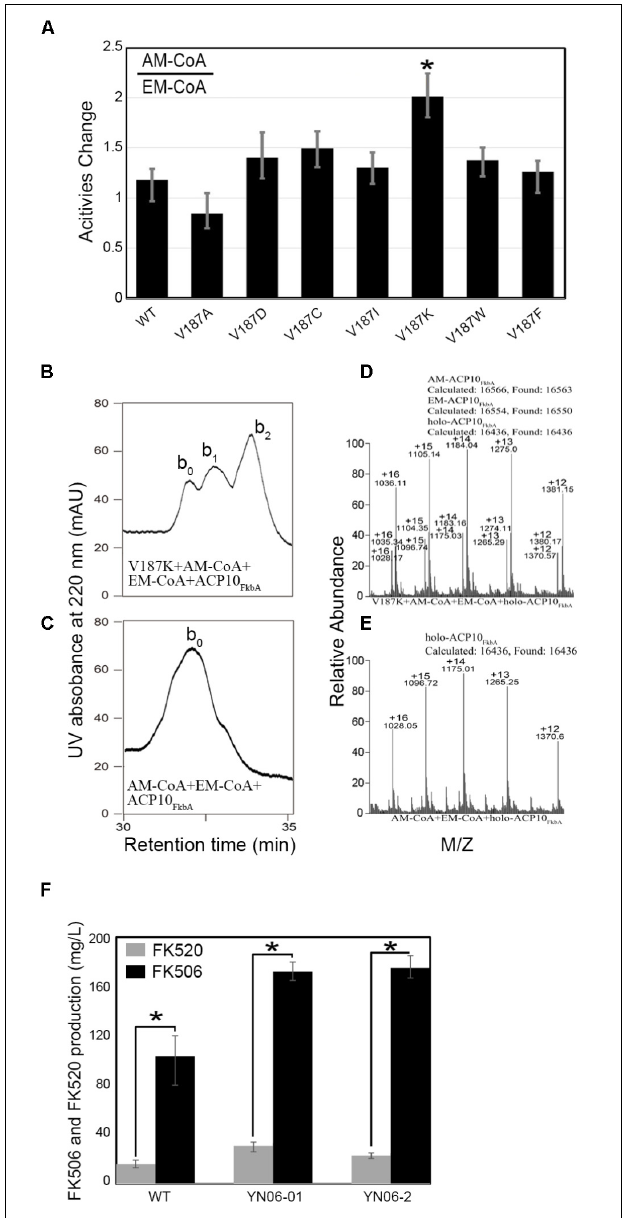
FIGURE 4 | Trans -acylation reaction assays of various AT4 FkbB mutants after substitution of Val187 with Asp, or Cys, Ile, Lys, Trp, and Phe with allmal- and ethmal-CoA as substrates and the Production of FK506 and FK520 in WT, YN06-01, and YN06-02. (A) The change of transferring allmal/ethmal unit to ACP10 FkbA in trans -acylation reactions by AT4 FkbB and its mutants V187D, V187C, V187I, V187K, V187W, and V187F. HPLC analyses of transferring allmal-CoA : ethmal-CoA = 1:1 to holo-ACP10 FkbA in the presence of V187K (B) and in the absence of AT4 FkbB (D) . MS analyses of transferring allmal-CoA : ethmal-CoA = 1:1 to holo-ACP10 FkbA in the presence of V187K (C) and in the absence of AT4 FkbB (E) . The peaks were assigned as follows: b 0 , holo-ACP10 FkbA ; b 1 , allmal-ACP10 FkbA ; b 2 , ethmal-ACP10 FkbA . (F) Production of FK506 and FK520 in WT, YN06-01 and YN06-02. Analyses of variance were conducted to determine the difference of WT and mutants using SPSS 20. The LSD multiple range tests were evaluated for significant differences among WT and mutants ( P < 0.01). The data are expressed as mean ± SE ( n = 3). ∗ P <